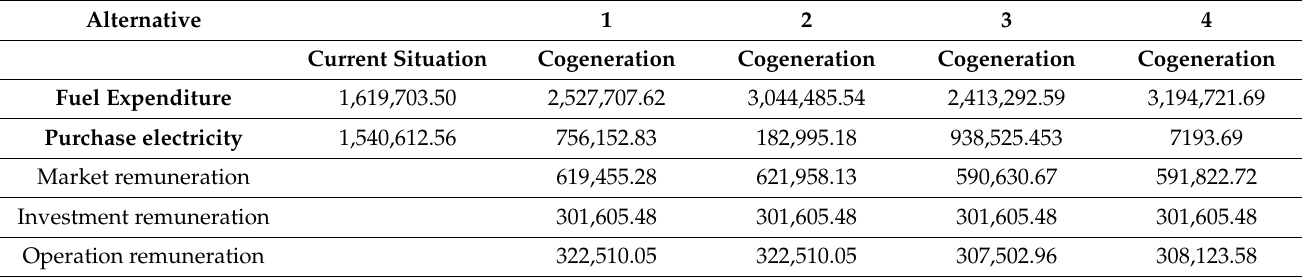
Table A3. Economic Balance ( € /year) for alternatives considering 4 MW fuel cell